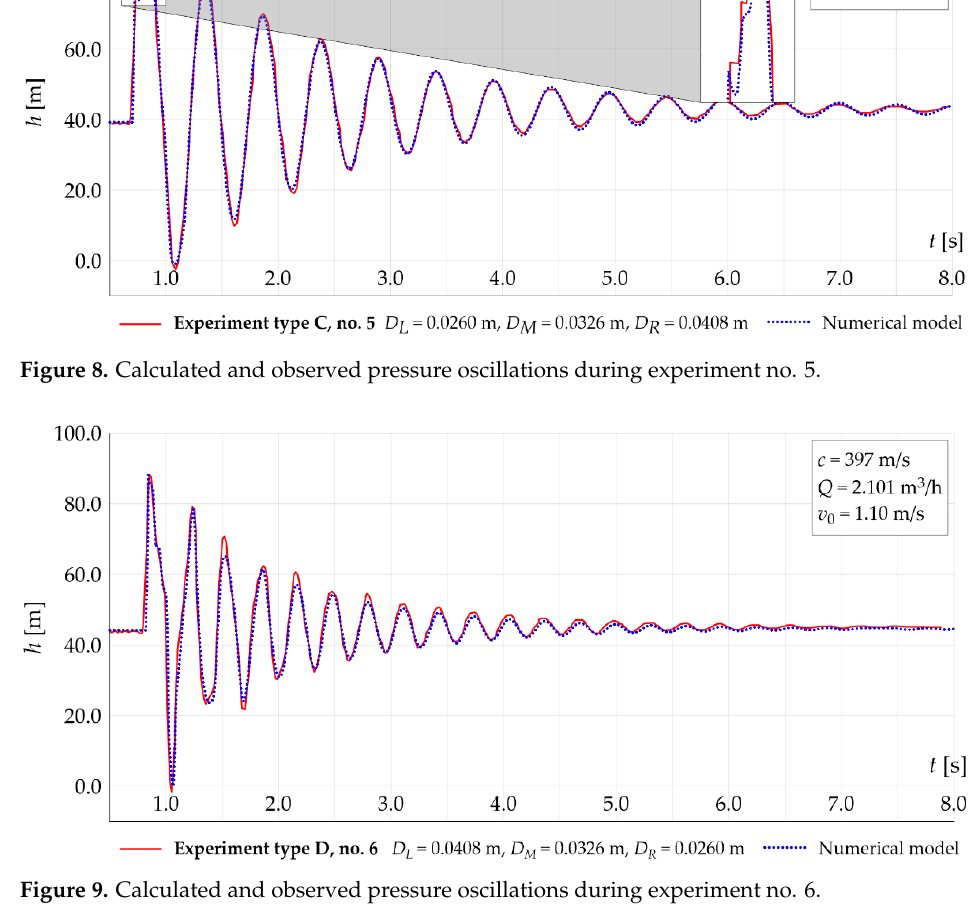
Figure 9. Calculated and observed pressure oscillations during experiment no. 6.